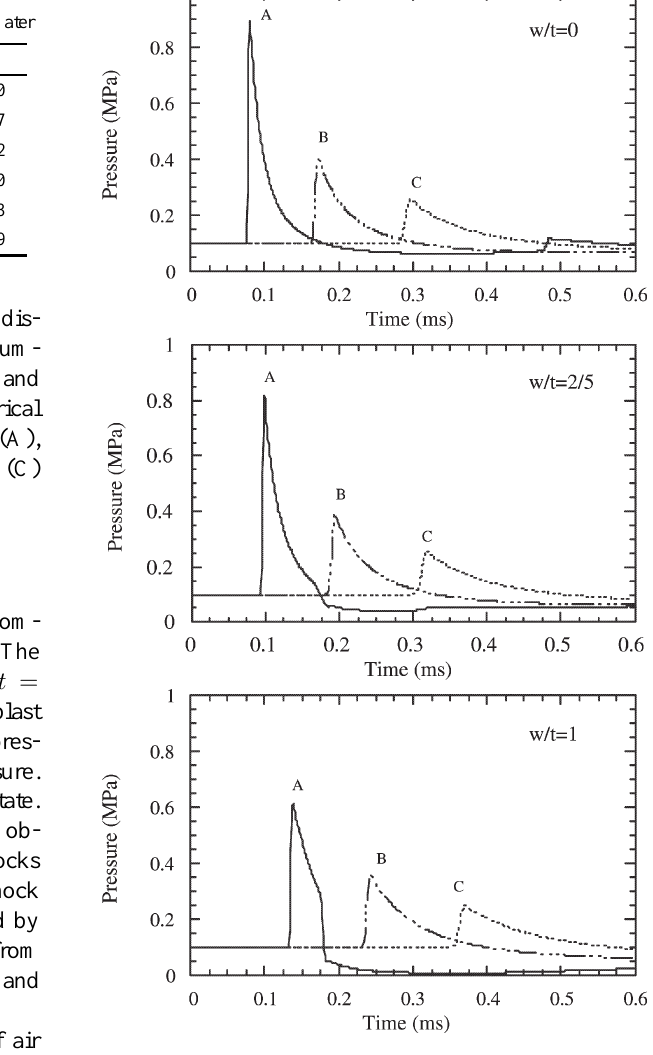
Fig. 4. Pressure signatures with contact watershield, w=t = 0, w=t = 2 , w=t = 5